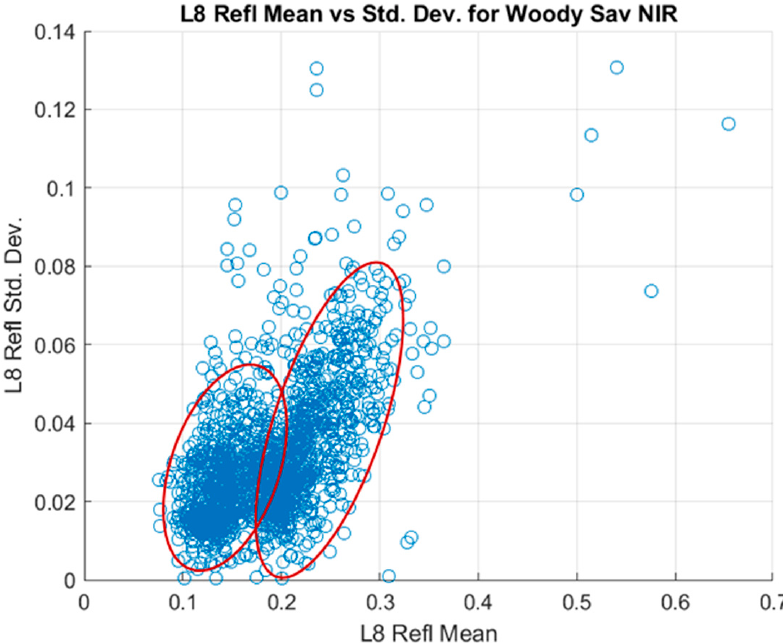
Figure 7. Signal to noise relationship of Woody Savanna NIR band. Note the two clusters of data points, which can be discerned by latitude.